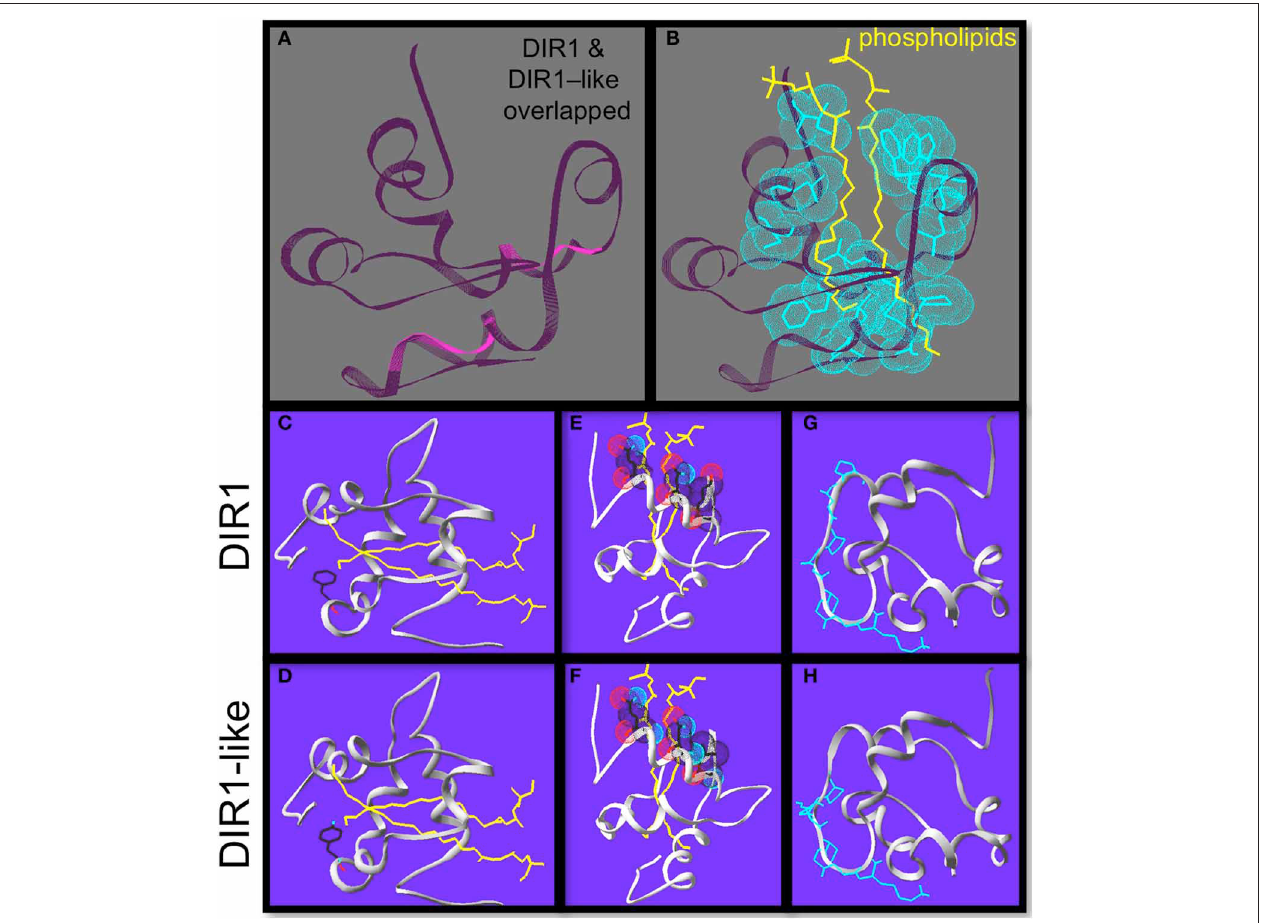
FIGURE 4 | Homology modeling reveals differences between DIR1 and DIR1-like protein structure. Homology modeling of DIR1-like protein using the DIR1 crystal structure as a template using the Swiss-pdb viewer 4.0.1 to compare the DIR1 structure and the DIR1-like protein model. (A) DIR1 protein backbone in dark purple is over-laid on the DIR1-like protein backbone in pink. (B) The two yellow phospholipids extend into the internal lipid binding pocket of DIR1. The 13 hydrophobic residues that make up the lipid binding pocket are highlighted with light blue van der